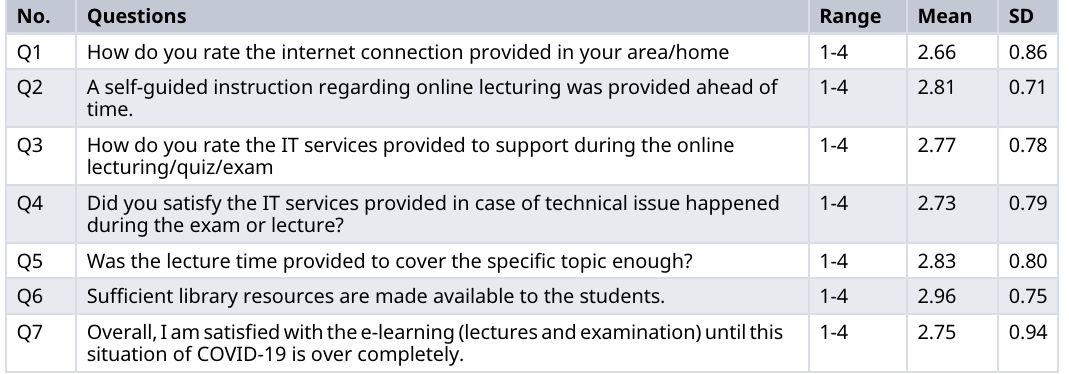
Table 3. Students' satisfaction score regarding technical support during the online teaching process.